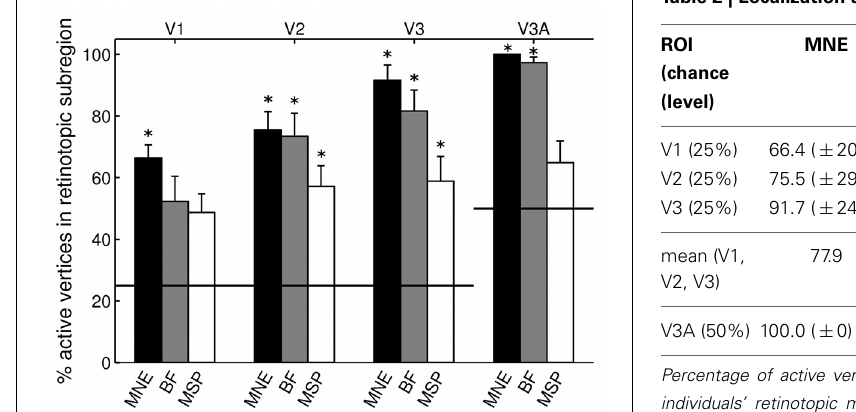
Table 2 | Localization accuracy for angular